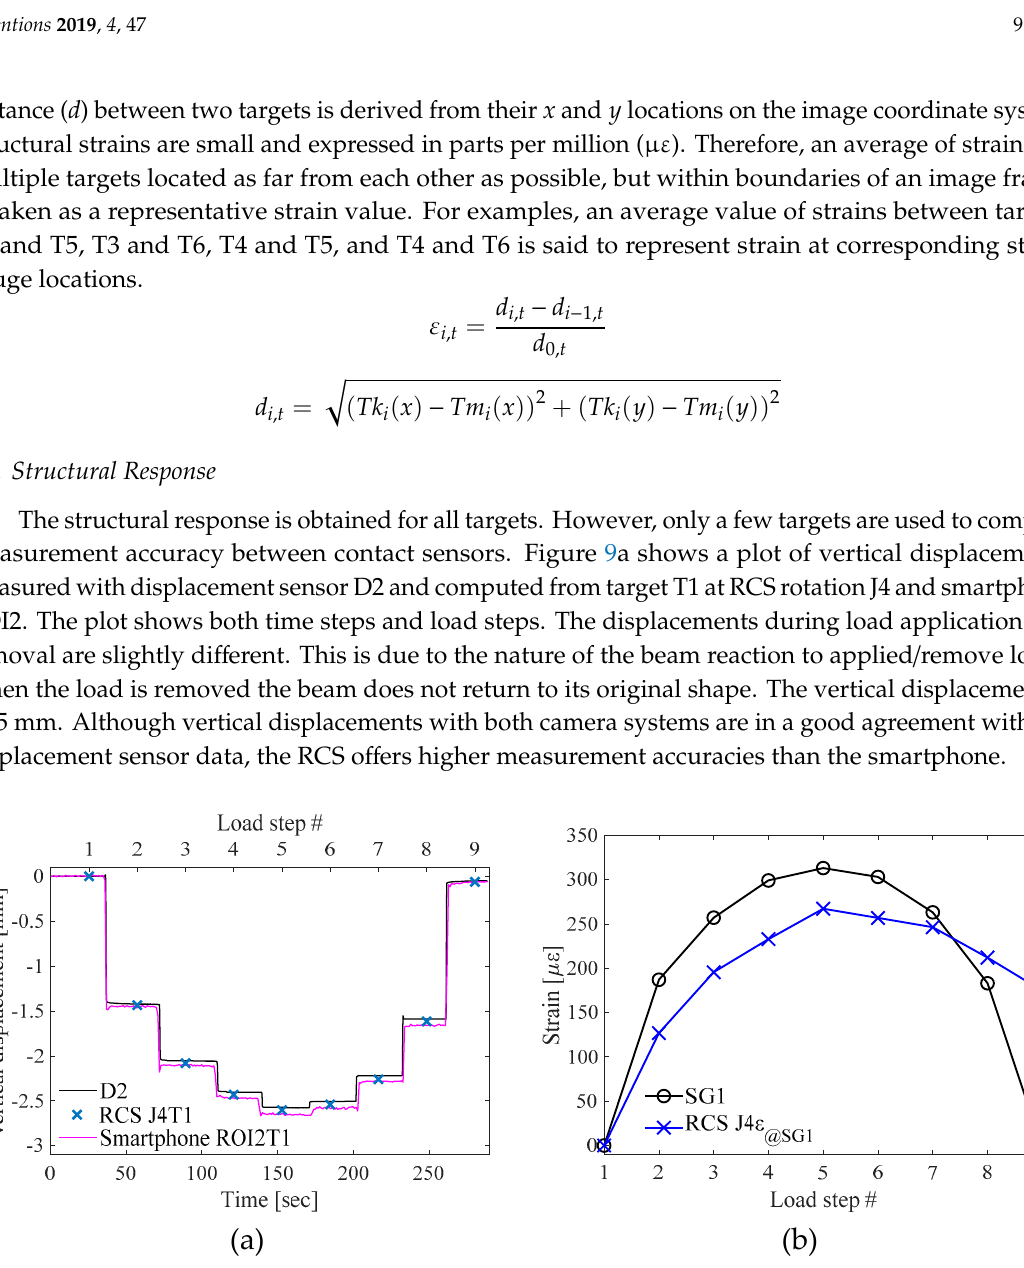
Figure 9. ( a ) Vertical displacements at D2 location. ( b ) Strain time-histories.